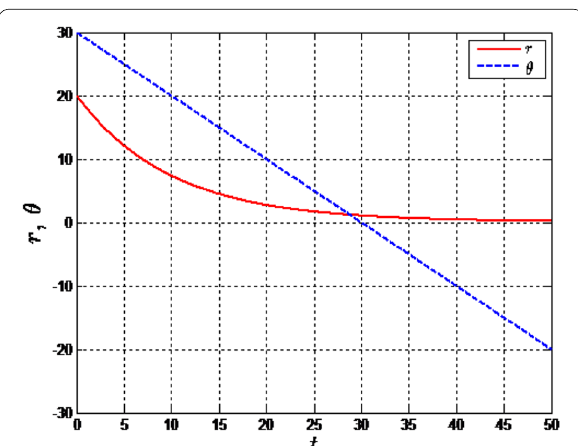
Figure 3 Histories of the particle in constrained system Eq. (57)